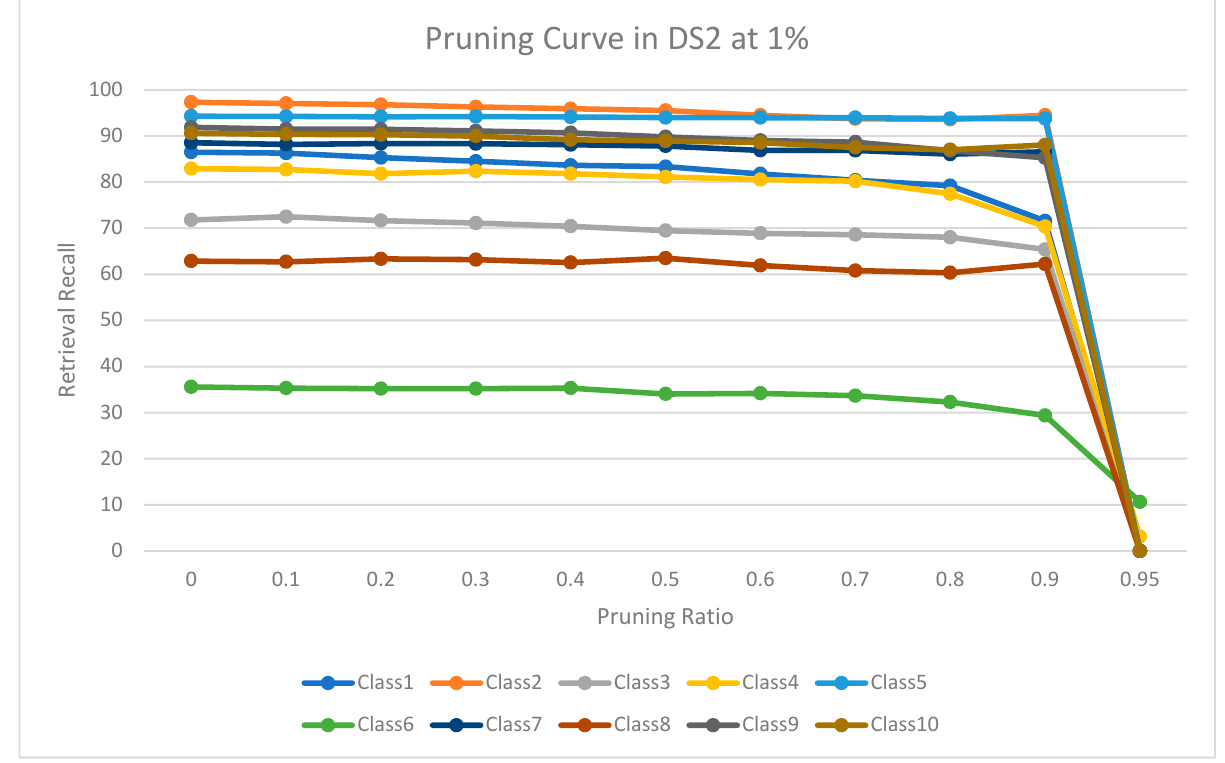
Figure 6. The level of retrieval recall values at different percentages of pruning at the top 1% in DDR-DR2.